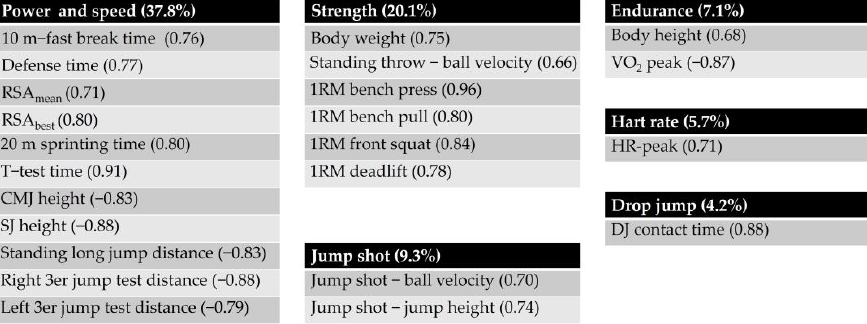
Figure 2. All elements ( loads of >0.60, respectively <−0.60) of the principal component factor analysis per each component including the percentage of variance.